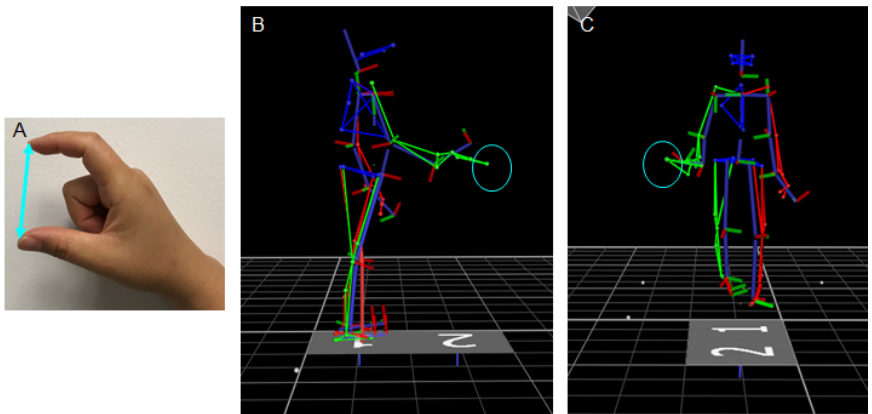
Figure 1. ( A ) A participant used her index finger and thumb to form a C-shaped pose to allow her hand aperture to be determined. The examiner measured the distance (cyan line) between the finger tips as the length of the participant’s hand aperture. ( B ) A skeleton figure, depicted in the sagittal plane to show a representative reaching while standing trial when the participant reached a target box (cyan circle). The target was set at one arm’s length from the participant in alignment with the midline of his body to allow him to bend forward to reach and lift the target. ( C ) A skeleton figure depicted in the frontal plane to show a representative walking-for-reaching trial prior to the participant reaching the target box (cyan circle). The participant reached the box with his trunk facing forward and the right arm slightly extended to the